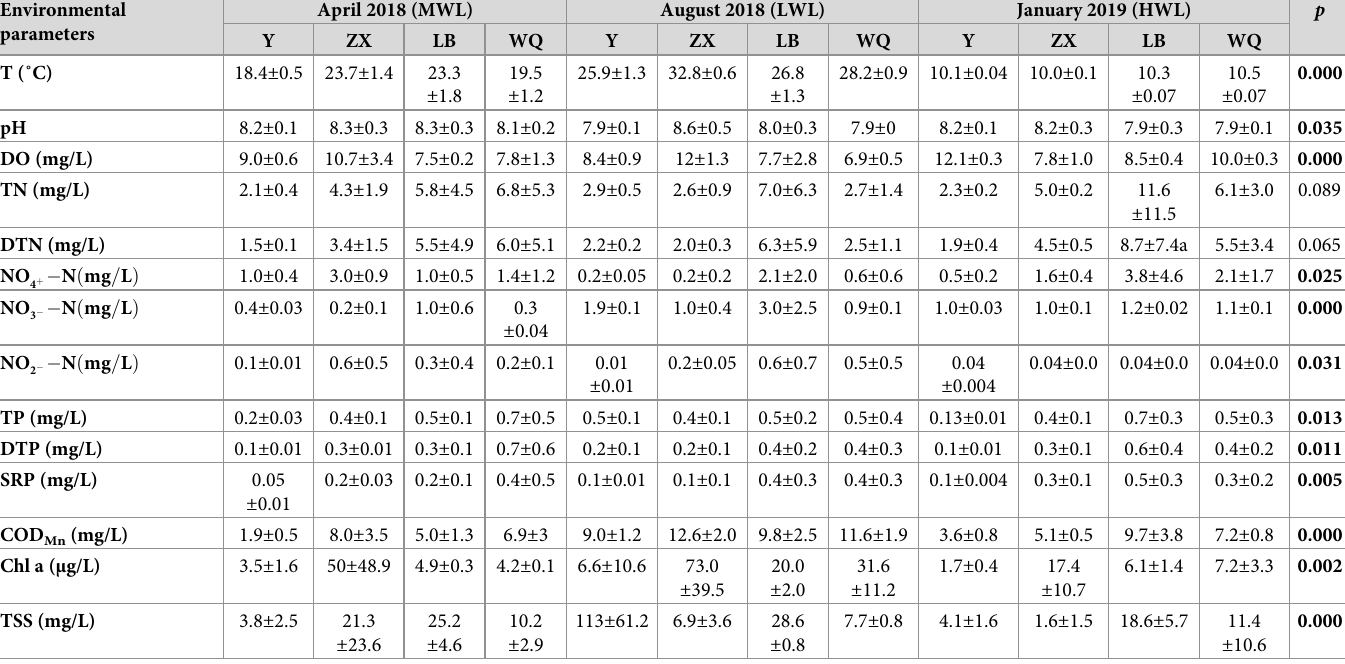
Table 1. Physical and chemical parameters of water quality in the Yangtze River and its tributaries. Environmental